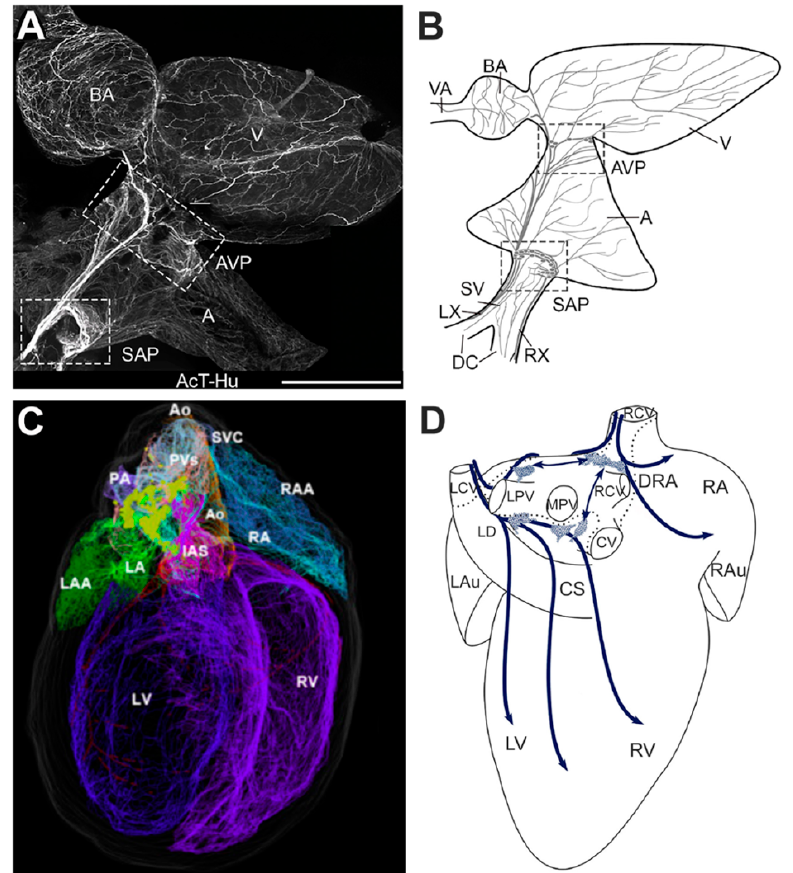
Figure 3. Intracardiac innervation of the zebrafish, rat and mouse hearts. ( A ) Whole mount immunostaining using antibodies directed against acetylated tubulin (AcT) and human neuronal protein (Hu) to label the ICNS of the zebrafish heart. ( B ) Schematic overview of the major elements of cardiac innervation. Boxed areas: sinoatrial plexus (SAP) and atrioventricular plexus (AVP). Abbreviations for A and B : A—atrium; AVP—atrioventricular plexus; BA—bulbus arteriosus; DC—ducts of Cuvier; LX and RX, left and right vagosympathetic trunks; SAP- sinoatrial plexus; SV—sinus venosus; V—ventricle; VA—ventral aorta (to the gills). ( C ) Posterior view of a 3D reconstructed male rat heart showing the context, extent, and distribution of the intrinsic cardiac neurons (yellow labelled), located on superior and posterior surfaces of the atria ( D ) Schematic overview of the intracardiac ganglia in the mouse heart, dorsal view. Dotted lines delineate the heart hilum, polygonal areas the main locations of the cardiac ganglia. Abbreviations for C and D : Ao- aorta; CS- coronary sinus veins; CV—caudal vein; DRA—dorsal right atrial; IAS—interatrial septum; LA—left atrium; LAA (or LAu)—left auricle; LCV—left cranial; LD—left dorsal; LPV—left pulmonary; LV—left ventricle; MPV—middle pulmonary veins: PA—pulmonary artery; PVs—pulmonary veins; RA—right atrium; RAA (or Rau) —right auricle; RCV—right cranial (superior caval) vein; RV—right ventricle; SVC—superior vena cava. Panel ( A - B ) reproduced with permission from Stoyek, M.R. et al., J. Comp. Neurol. Published by Wiley, 2015 [78]. ( C ) Reproduced with permission from Achanta, S. et al. iScience published by Elsevier, 2020 [81] ( D